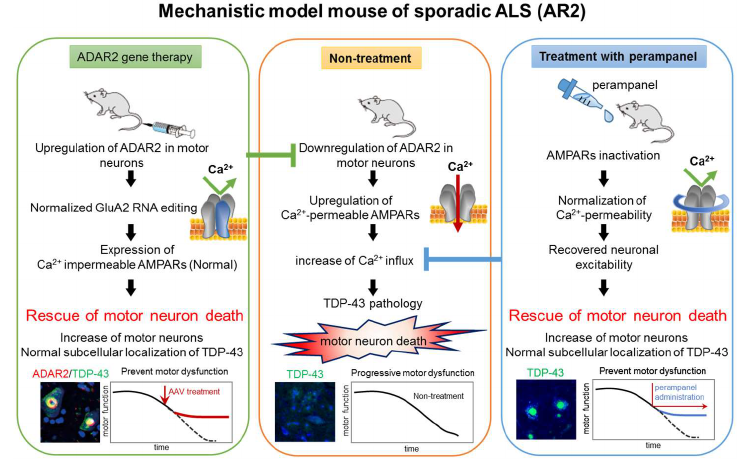
Figure 8. Mechanism-Based strategy for amyotrophic lateral sclerosis (ALS) therapy. Both gene therapy using adeno-associated virus as a vector (AAV9- ADAR2 gene therapy) and treatment with perampanel significantly prevented the progression of ALS phenotypes in conditional adenosine deaminase acting on RNA 2 (ADAR2) knockout mice (AR2) by preventing transactive response DNA-binding